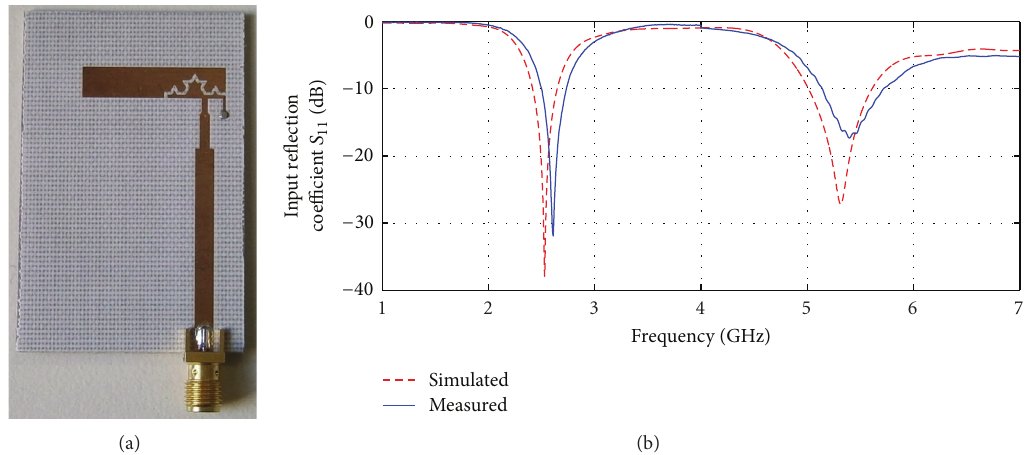
Figure 15: (a) Prototype dual-band PIFA reactively loaded by a K2 slot. (b) Comparison of numerical and experimental magnitudes of the reflection coefficient at the input to the dual-band K2 PIFA.